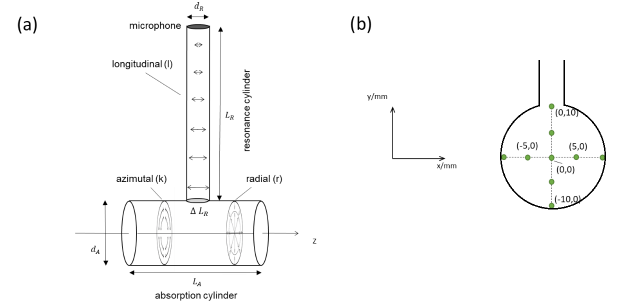
Figure 1. (a) Scheme of the T-cell including possible acoustic modes (side view), with d denoting the cylinder diameters and L the cylinder lengths, (cid:49)L R is the end correction. Light passes the absorption cylinder in z direction, (b) Front view on the absorption cylinder with different positions of the laser beam in x and y , as described in the experimental section.